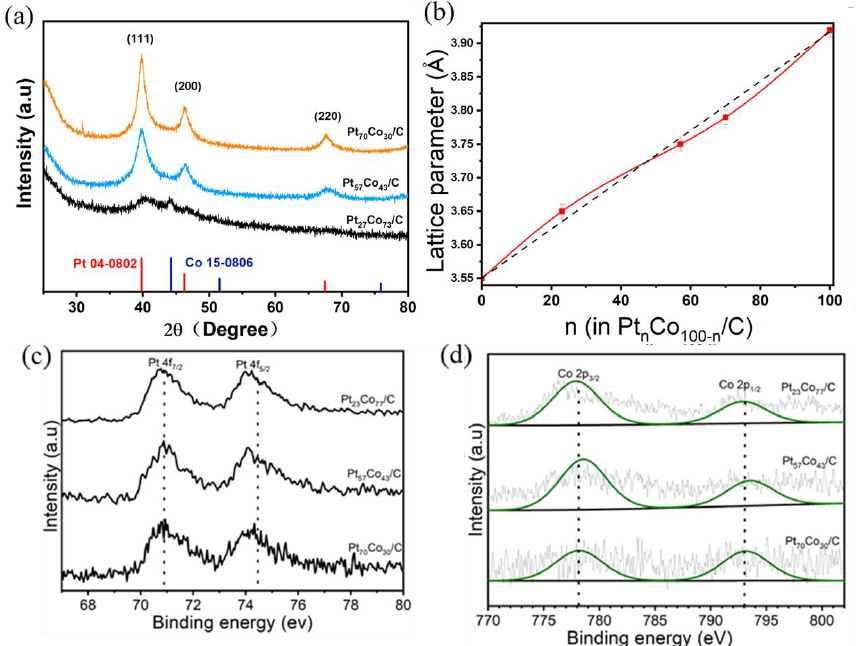
Figure 2. ( a ) XRD patterns of NWs. ( b ) Lattice parameters for NWs on the relative composition of Pt%. XPS spectra and deconvoluted peaks in the regions of ( c ) Pt 4f and ( d ) Co 2p. The international standard (C 1s) was used to calibrate the peak position.